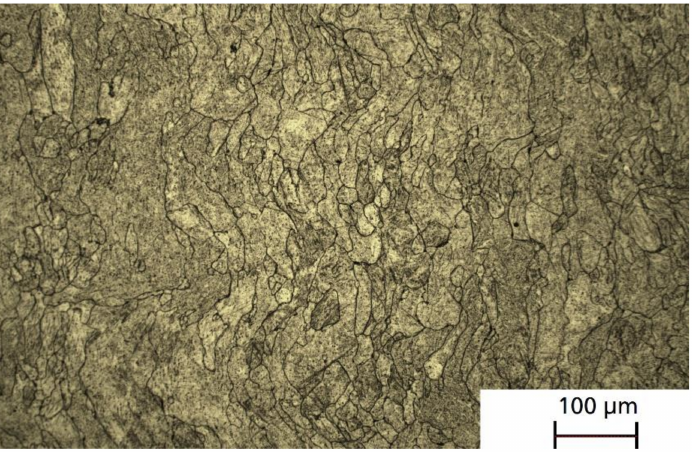
Figure 5. Optical micrograph of metallographic cross-section of PBF-EB processed X37CrMoV5-1. Build direction is vertical. The main processing parameters were beam power 480 W, scan speed 1530 mm/s and hatch distance 50 µ